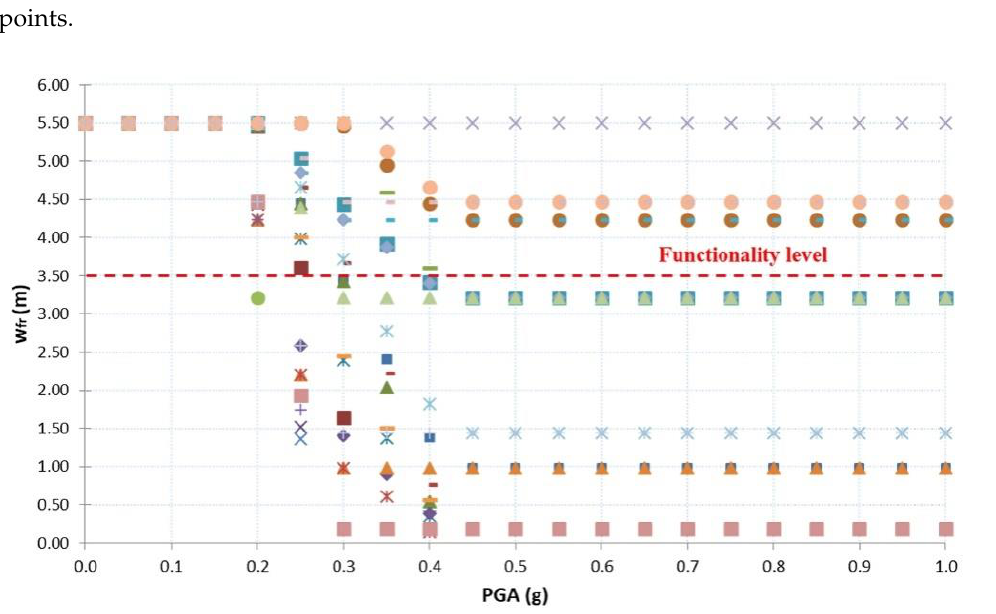
Figure 5. Example of width values of the road pavement that remains free after the debris fall ( w fr ) for a given set of intensity measure ( IM ) levels.